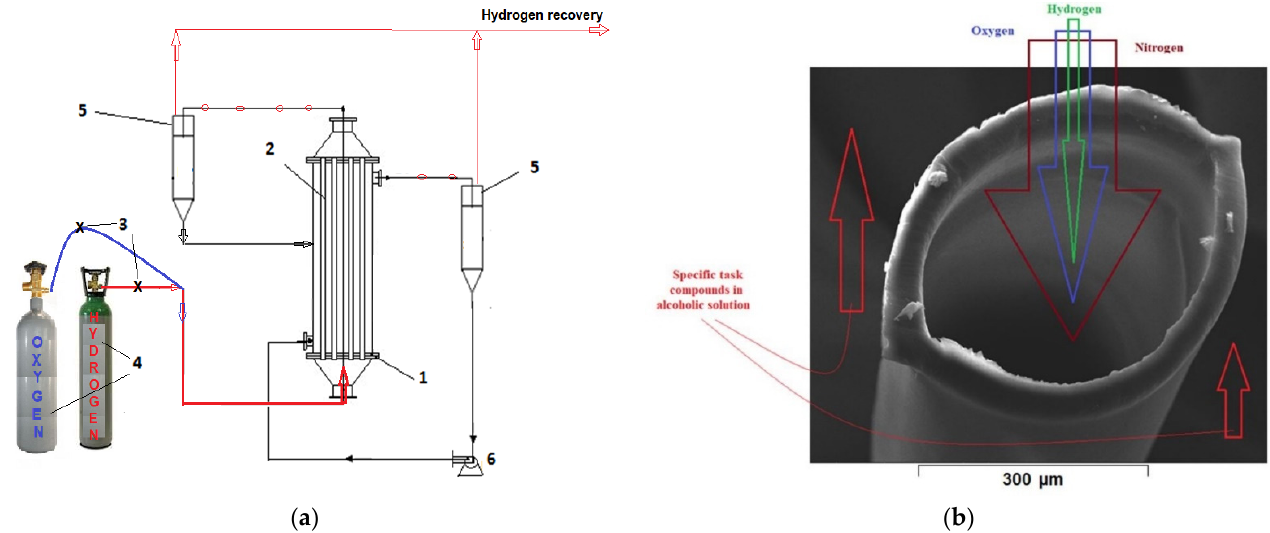
Figure 4. ( a ) The schematic presentation of the 10-undecylenic acid oxidation or p- nitrophenol reduction installation: 1: membrane contactor; 2: polypropylene hollow fiber membranes; 3, 4: hydrogen or oxygen source; 5: gas-liquid separator; 6: pump for solution in tert- butyl alcohol (methanol, ethanol, or propanol); and ( b ) fluid circulation through the system.